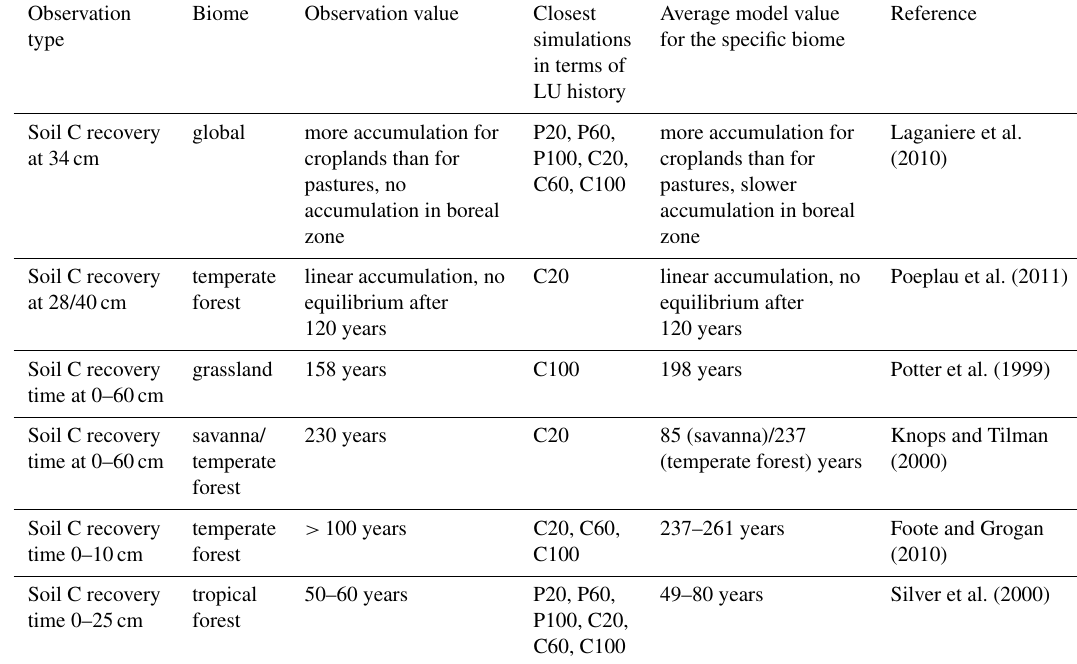
Table 3. Observations and LPJ-GUESS results of soil C changes during agriculture (cropland and/or pasture) and vegetation and soil C recovery after